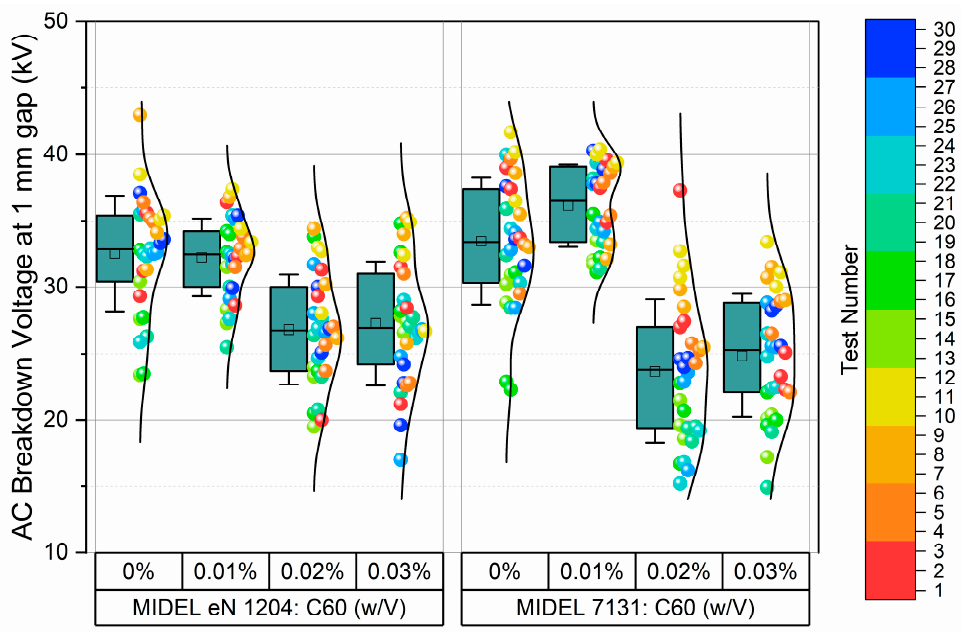
Figure 3. The box plot of AC BDV data defined by the first and third quartiles. The data are presented for the pure esters and nanofluids with fullerene nanoparticles. The medians are shown in the graph as a thick line and the mean value position is portrayed as a square inside each data box. The line segments which pass by each box represent the standard deviation σ , and kernel density is displayed as a curve on the right side of each box. Dots with colors from red to blue represent the first and last measurements of AC BDV, respectively.